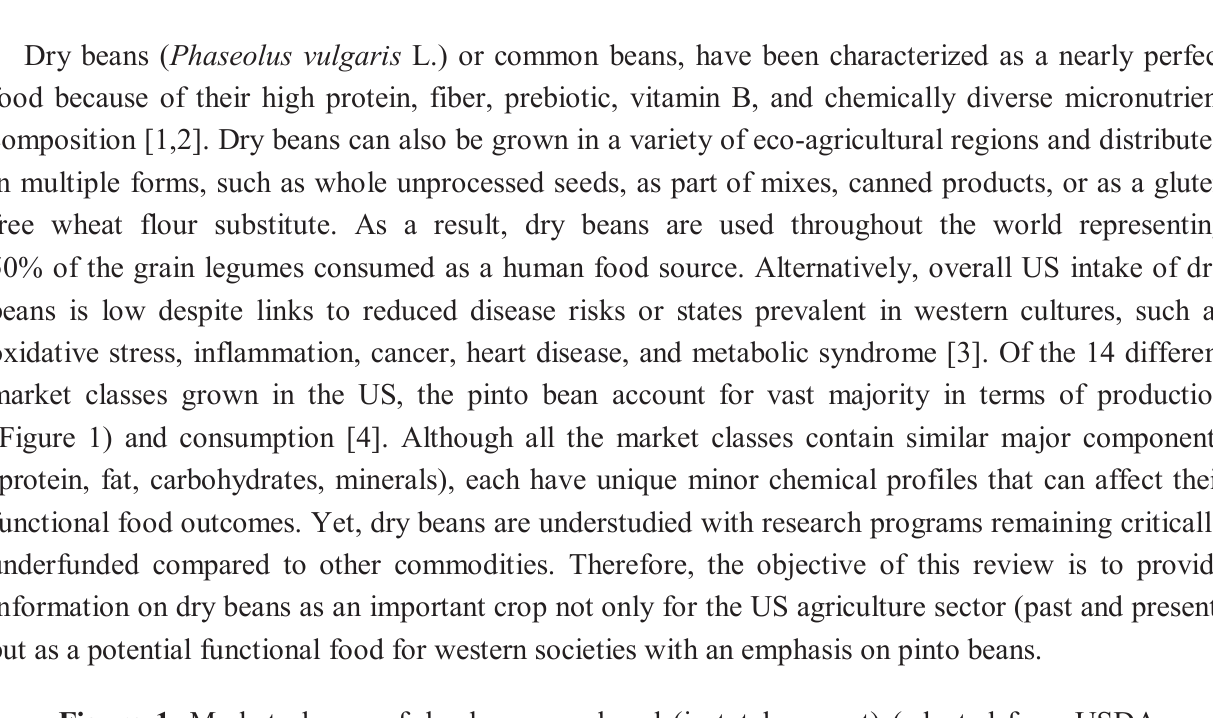
Figure 1. Market classes of dry beans produced (in total percent) (adapted from USDA data [4]). (Others include small white, light red kidney, dark red kidney, lima, black-eyed, cranberry, and